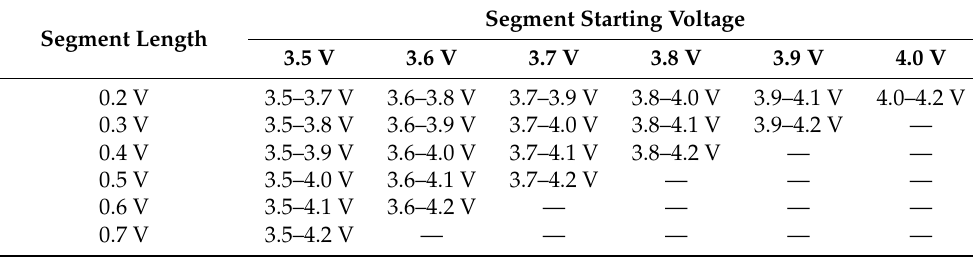
Table 3. Segmentation information of IC